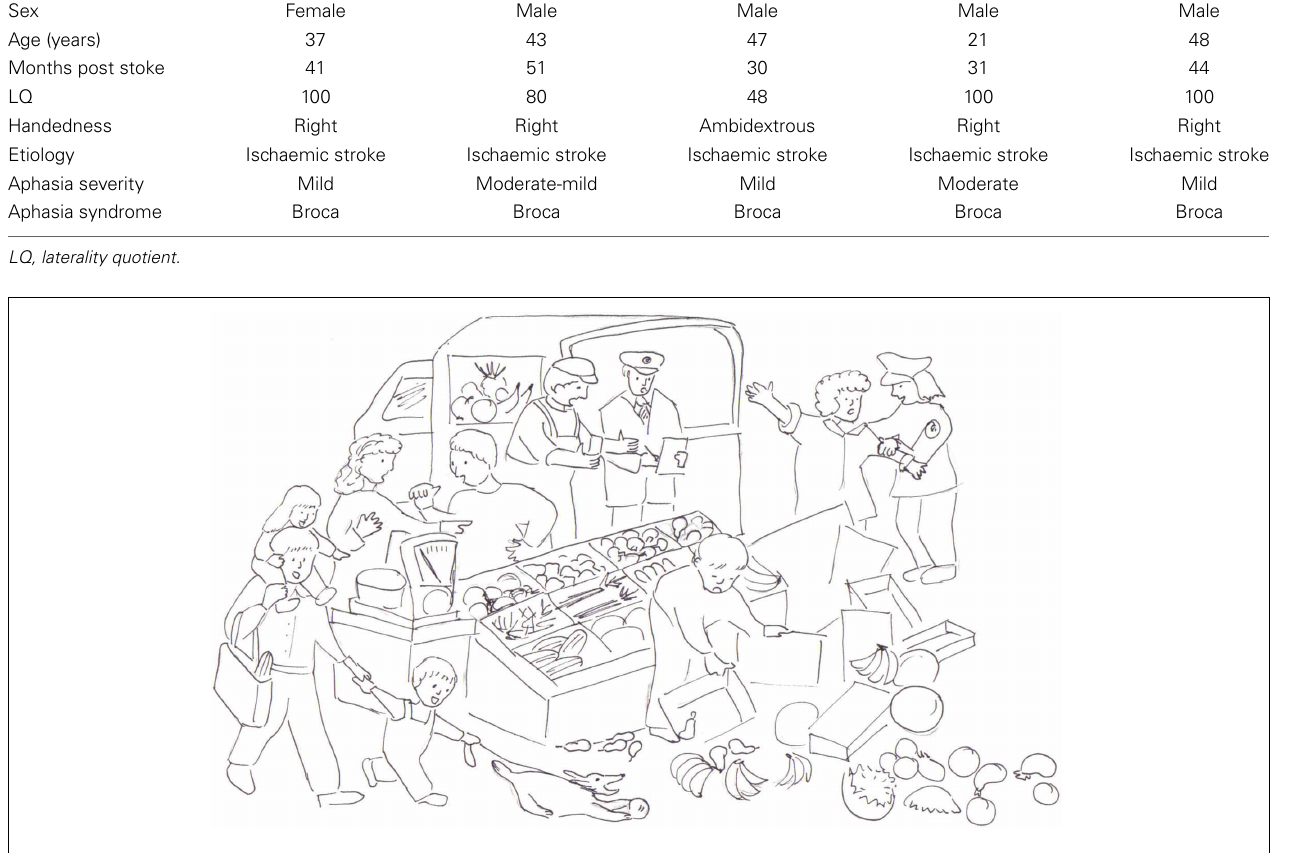
FIGURE 2 | Example of stimulus